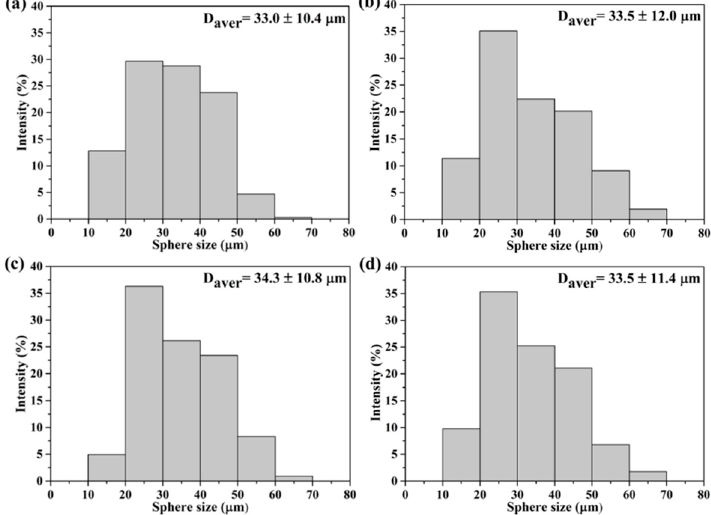
Figure 2. Histograms of sphere size distributions of ( a ) 0, ( b ) 5, ( c ) 10 and ( d ) 20 wt.% PMMA-treated BG microspheres.